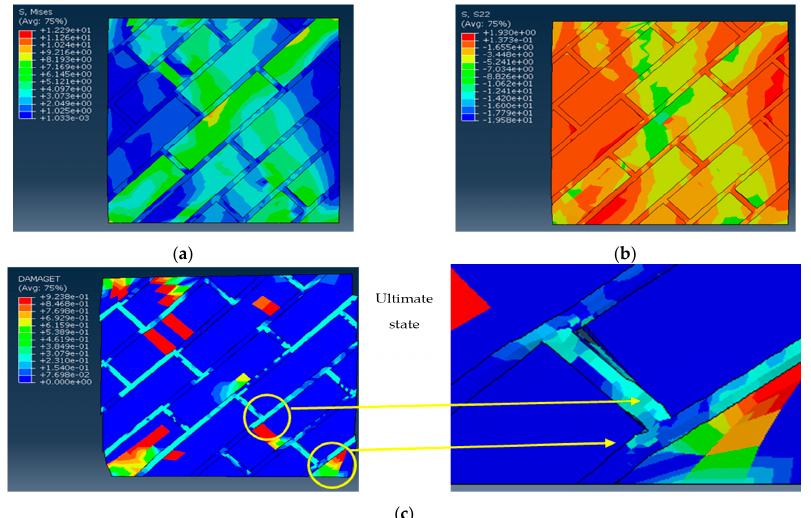
Figure 14. ( a ) Von Mises stress; ( b ) normal stress in the direction y (S22); ( c ) evolution of damage in unreinforced wall MTB ( θ = 45°).